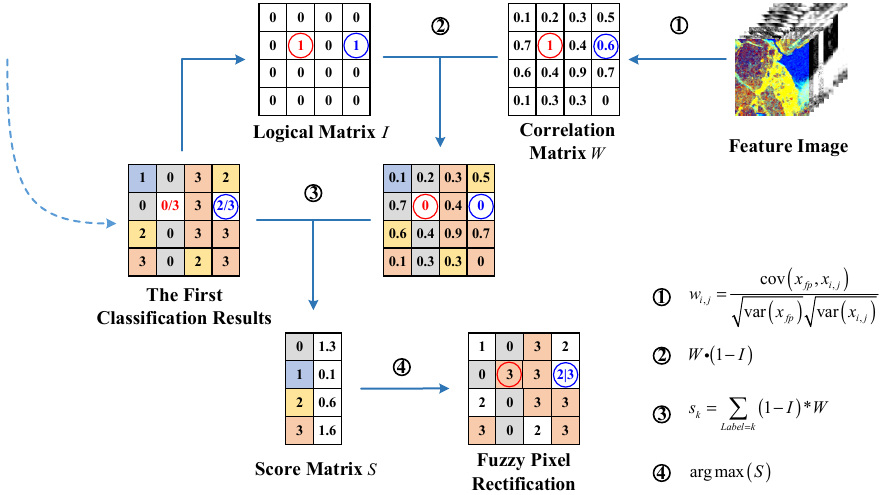
Figure 6. Second weight voting stage rectifying fuzzy pixels based on the local similarity of the neighboring explicit pixels.